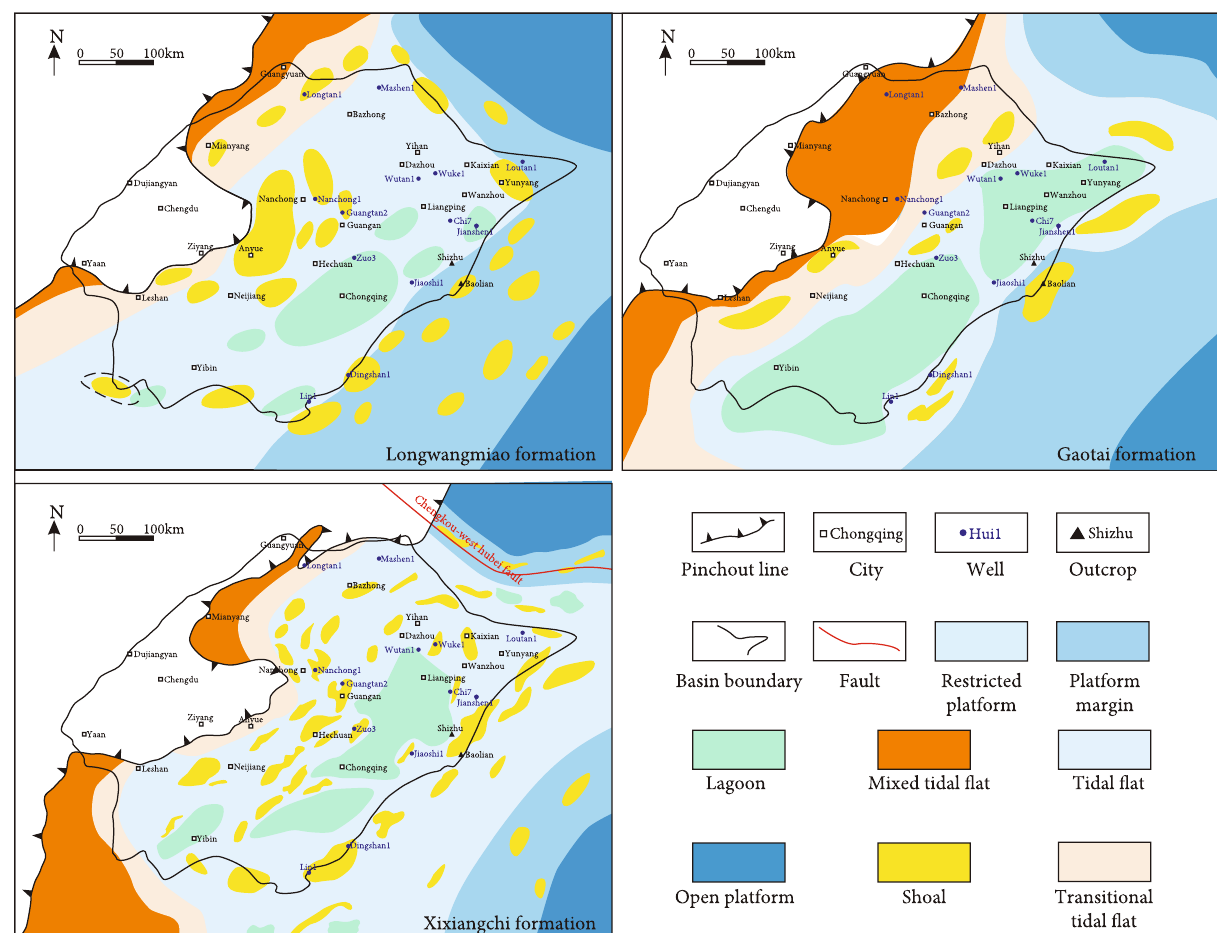
Figure 11: Sedimentary facies of the Cambrian Longwangmiao Formation, the Gaotai Formation, and the Xixiangchi Formation in Sichuan